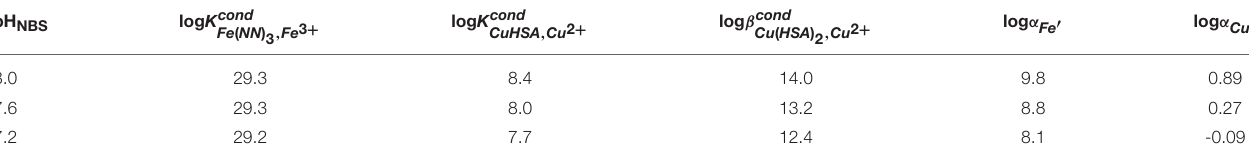
TABLE 2 | Conditional stability constants for added ligands and inorganic side reaction coefficients for iron and copper used in this study. pH